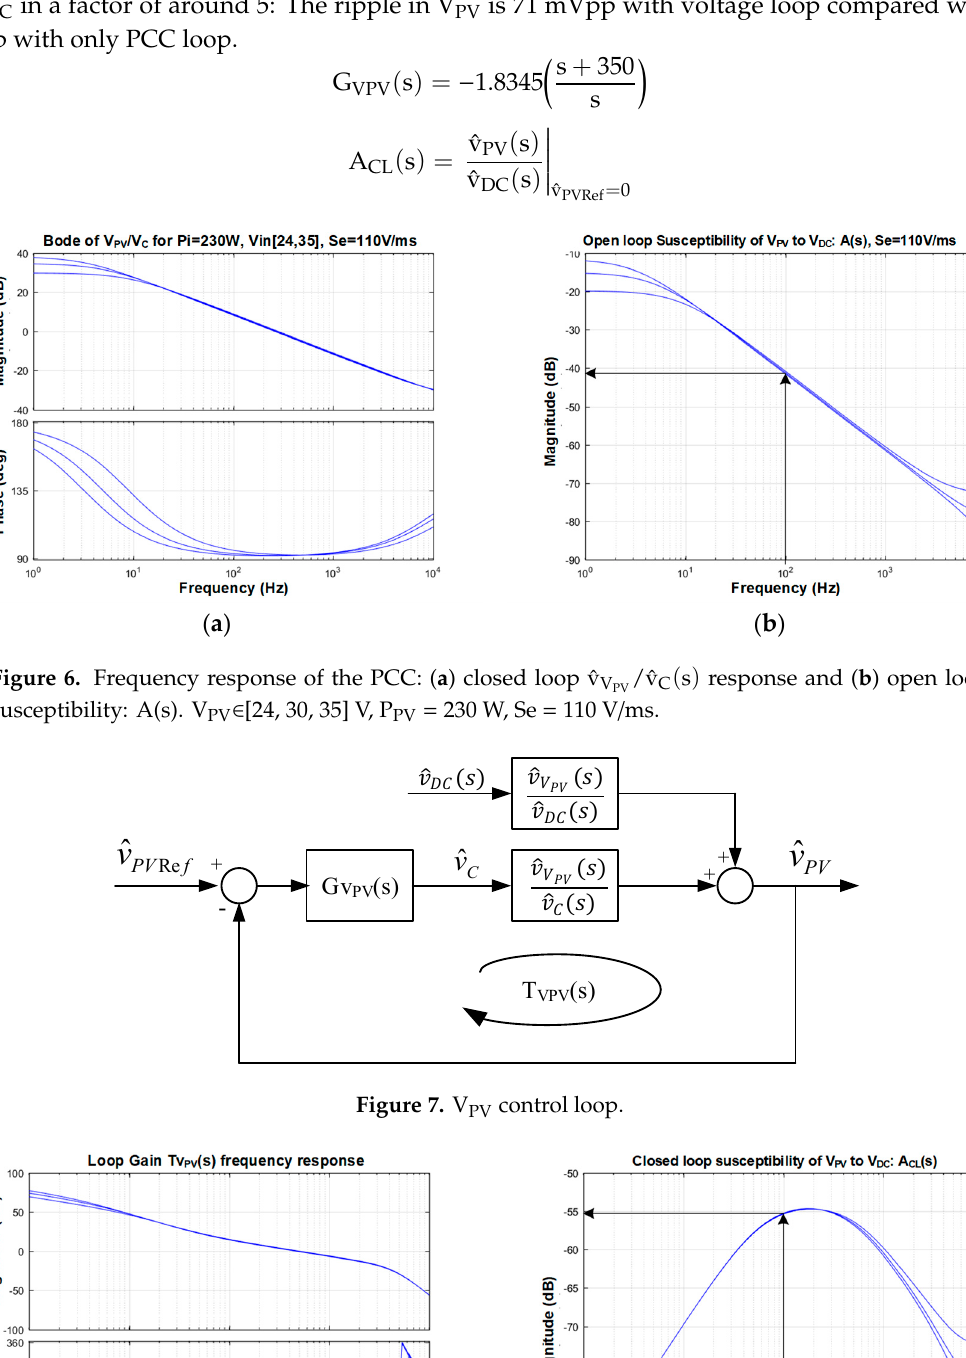
v(cid:3548) (cid:2887) ⁄ (s) response and ( b ) open loop (cid:3148)(cid:3154)